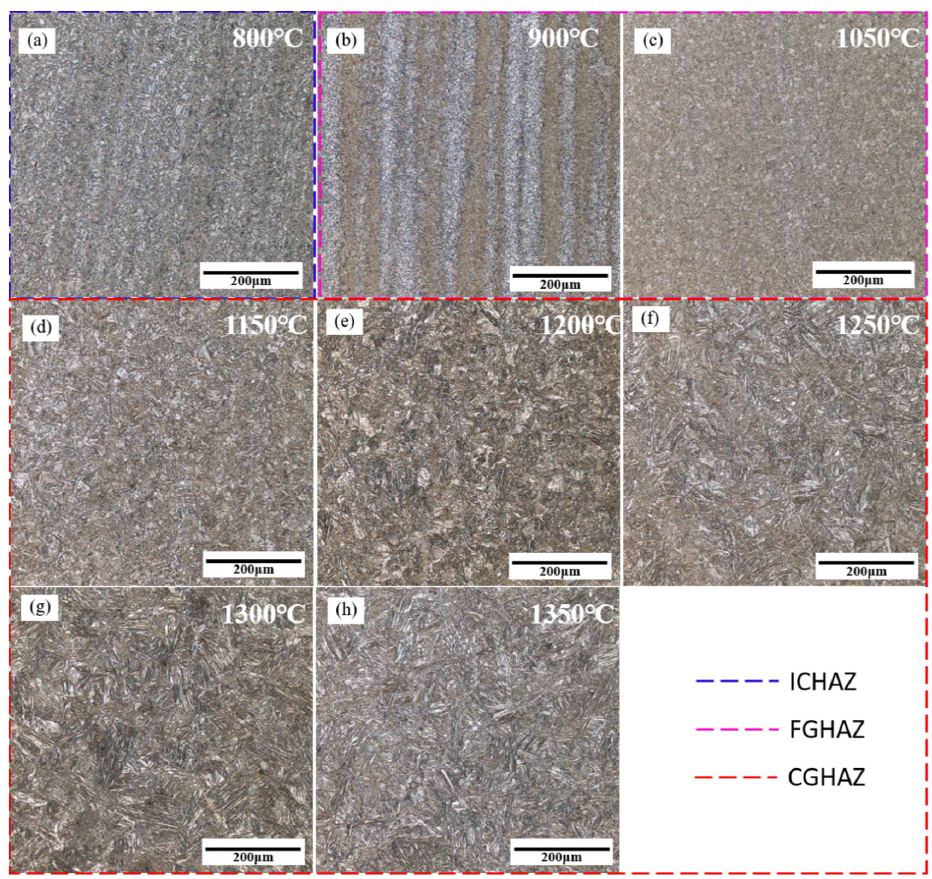
Figure 4. Microstructure of simulated HAZ at different peak temperatures. ( a ) 800 °C, ( b ) 900 °C, ( c ) 1050 °C, ( d ) 1150 °C, ( e ) 1200 °C, ( f ) 1250 °C, ( g ) 1300 °C, and ( h ) 1350 °C.